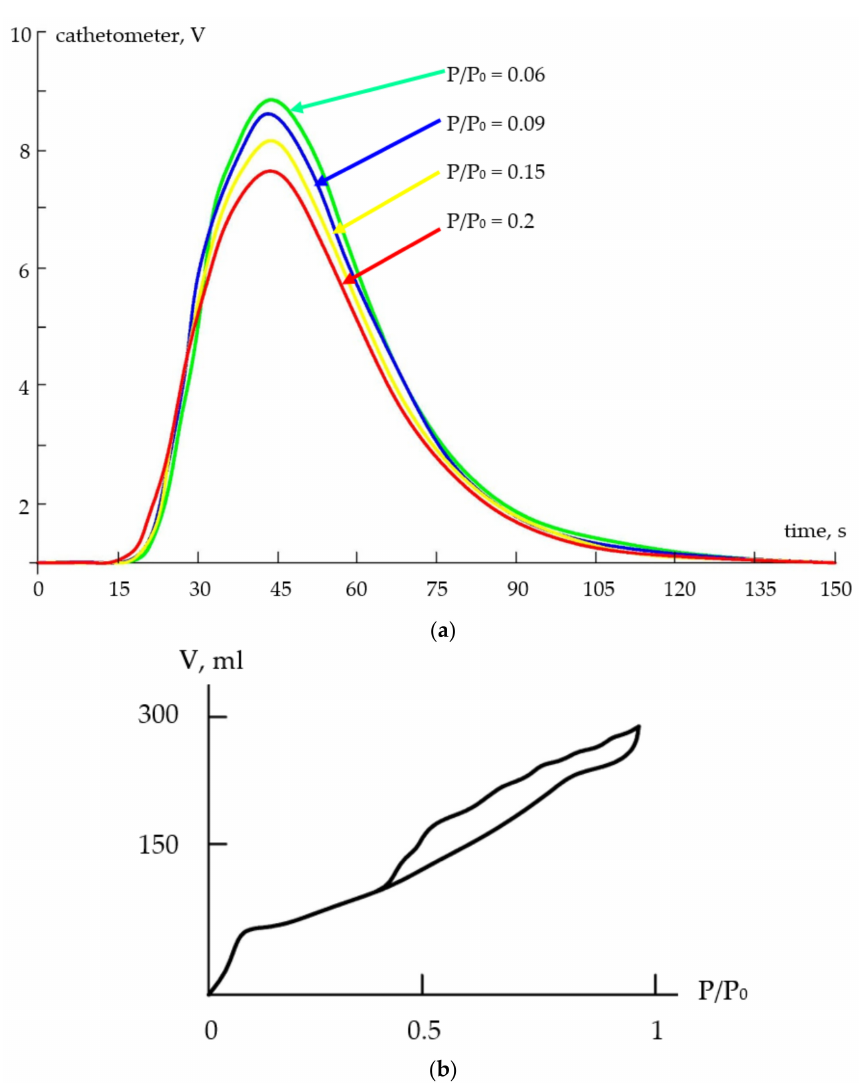
Figure 13. ( a ) Signals received from thermal conductivity meter formed during adsorption analysis; ( b ) a typical adsorption